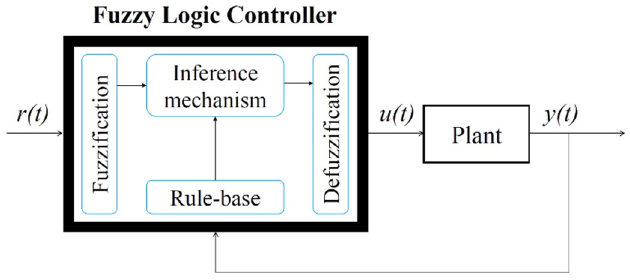
Figure 3. Fuzzy logic controller system block diagram: r ( t )—reference input, u ( t )—process inputs, y ( t ) — process.